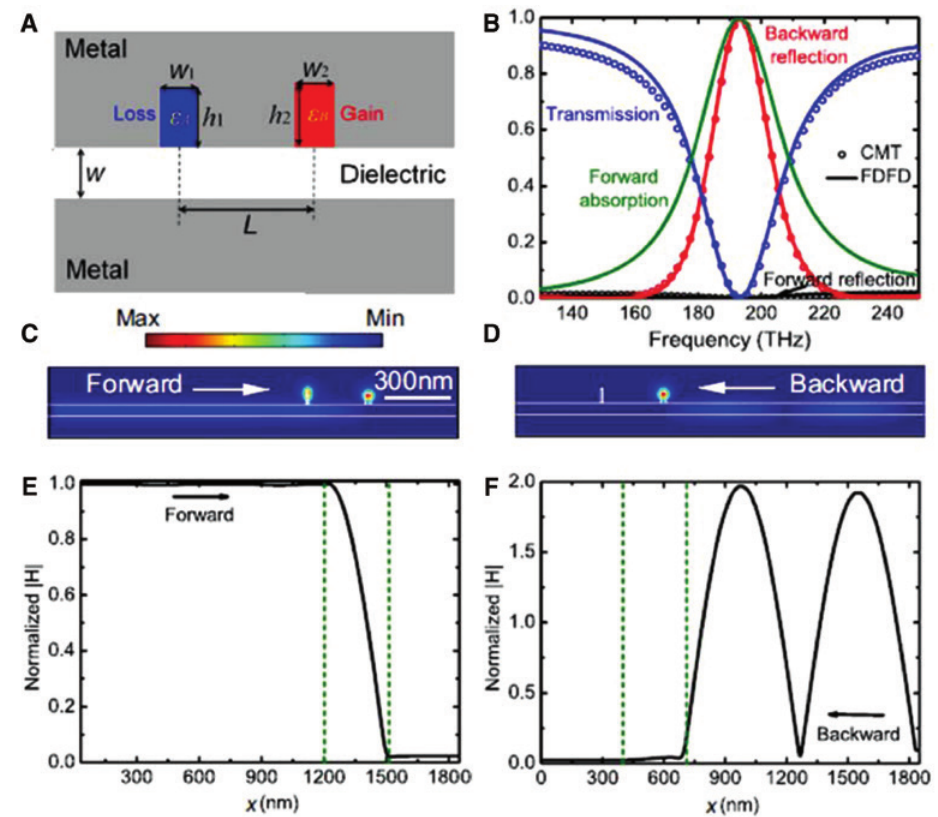
Figure 10: Unidirectional reflectionlessness of a non- PT -symmetric system consisting of a MDM plasmonic waveguide side coupled to two MDM stub resonators with unbalanced gain and